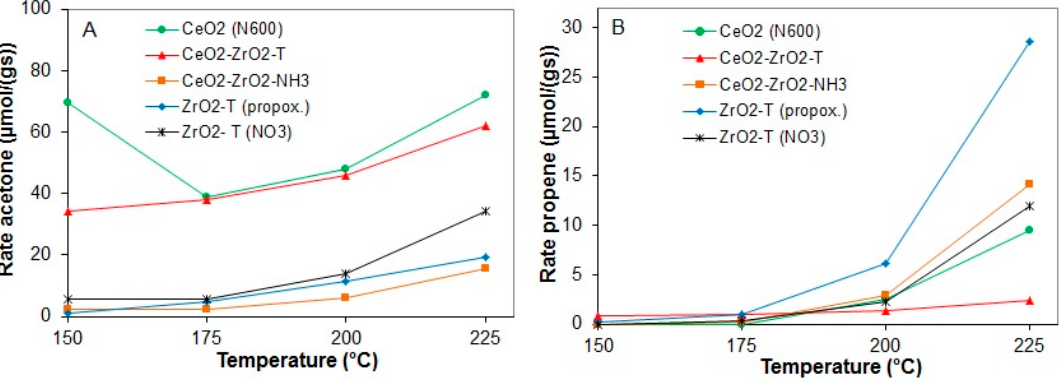
Figure 11. Rates of acetone production (A) and propene production (B) at 150 to 225 °C for various pre-treated catalysts.